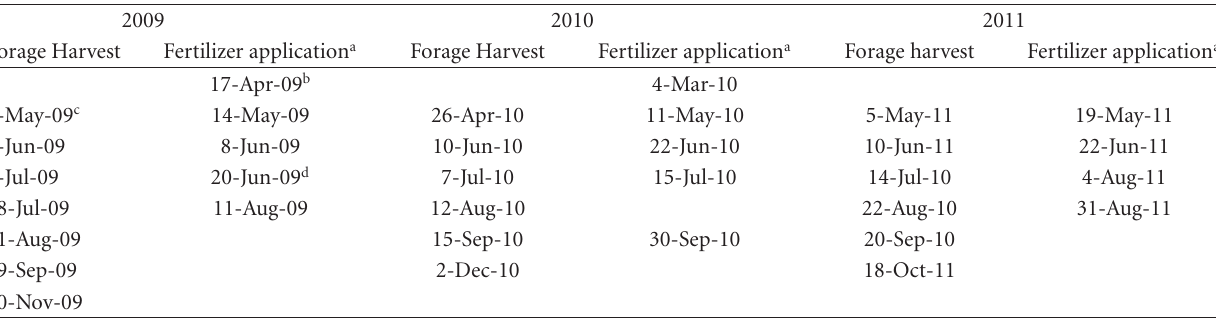
30-Nov-09 a Soil samples taken 1-day prior to fertilizer application. b Early season manure application by grower, prior to plot establishment. c Harvest prior to plot establishment, yield data from this harvest does not include replicates. d Unintended slurry application from